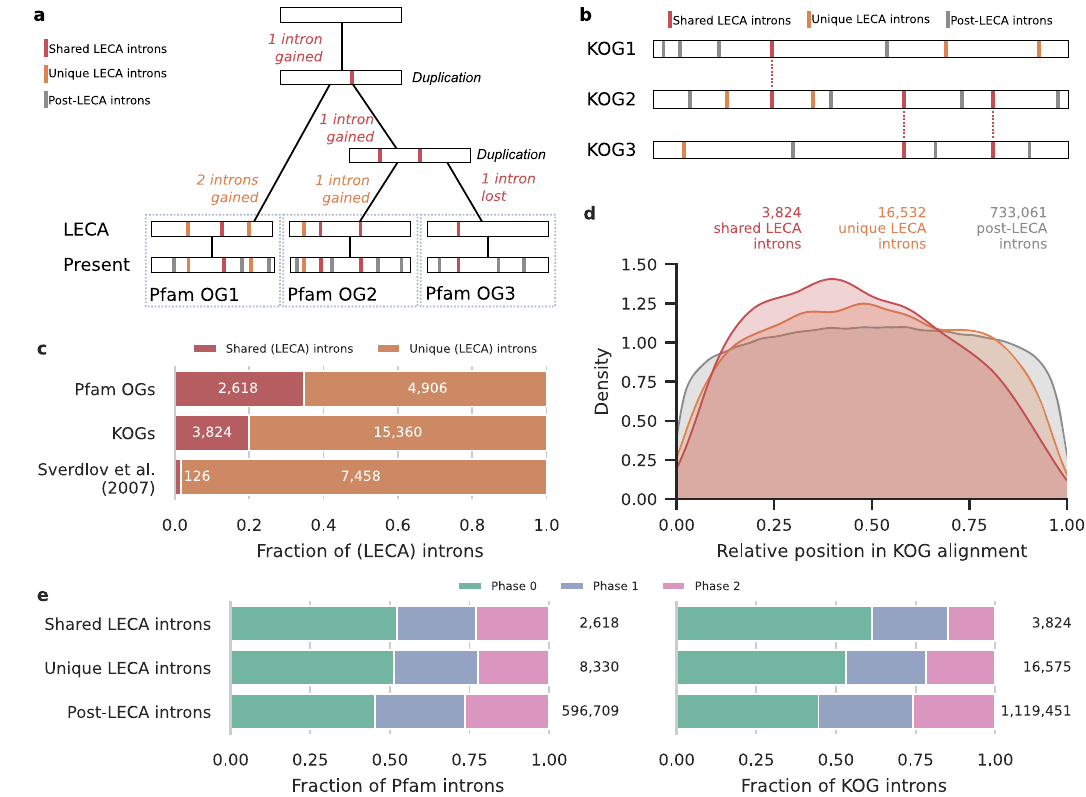
Fig. 1 Characteristics of unique and shared LECA introns. a The reconstruction of introns in LECA (Pfam orthogroups (OGs)), distinguishing unique LECA introns and shared LECA introns that likely originated before a duplication. Pfam OG1-3 represent three paralogous Pfam OGs that resulted from two duplications during eukaryogenesis, as indicated. b The comparisons of intron positions in KOGs within a cluster, identifying post-LECA introns, unique LECA introns and LECA introns shared between KOGs. KOG1-3 represent three paralogous KOGs in a cluster that resulted from two gene duplications during eukaryogenesis. c Fraction of shared LECA introns in the two datasets used in this study, in comparison with the fraction of shared introns as calculated in Sverdlov et al. 18 . d Density plot showing the relative positions of introns in the alignment of a KOG. The three distributions are all signi fi cantly distinct from one another according to Kolmogorov – Smirnov tests. e Intron phase distributions in Pfam OGs and KOGs. All pairwise comparisons were signi fi cant, except shared LECA versus unique LECA Pfam introns (Supplementary Tables 1, 2). Numbers in c – e indicate the number of introns different (Fig. 1e; χ 2 = 966, df = 4, P = 8.1 × 10 − 208 (KOGs); χ 2 =